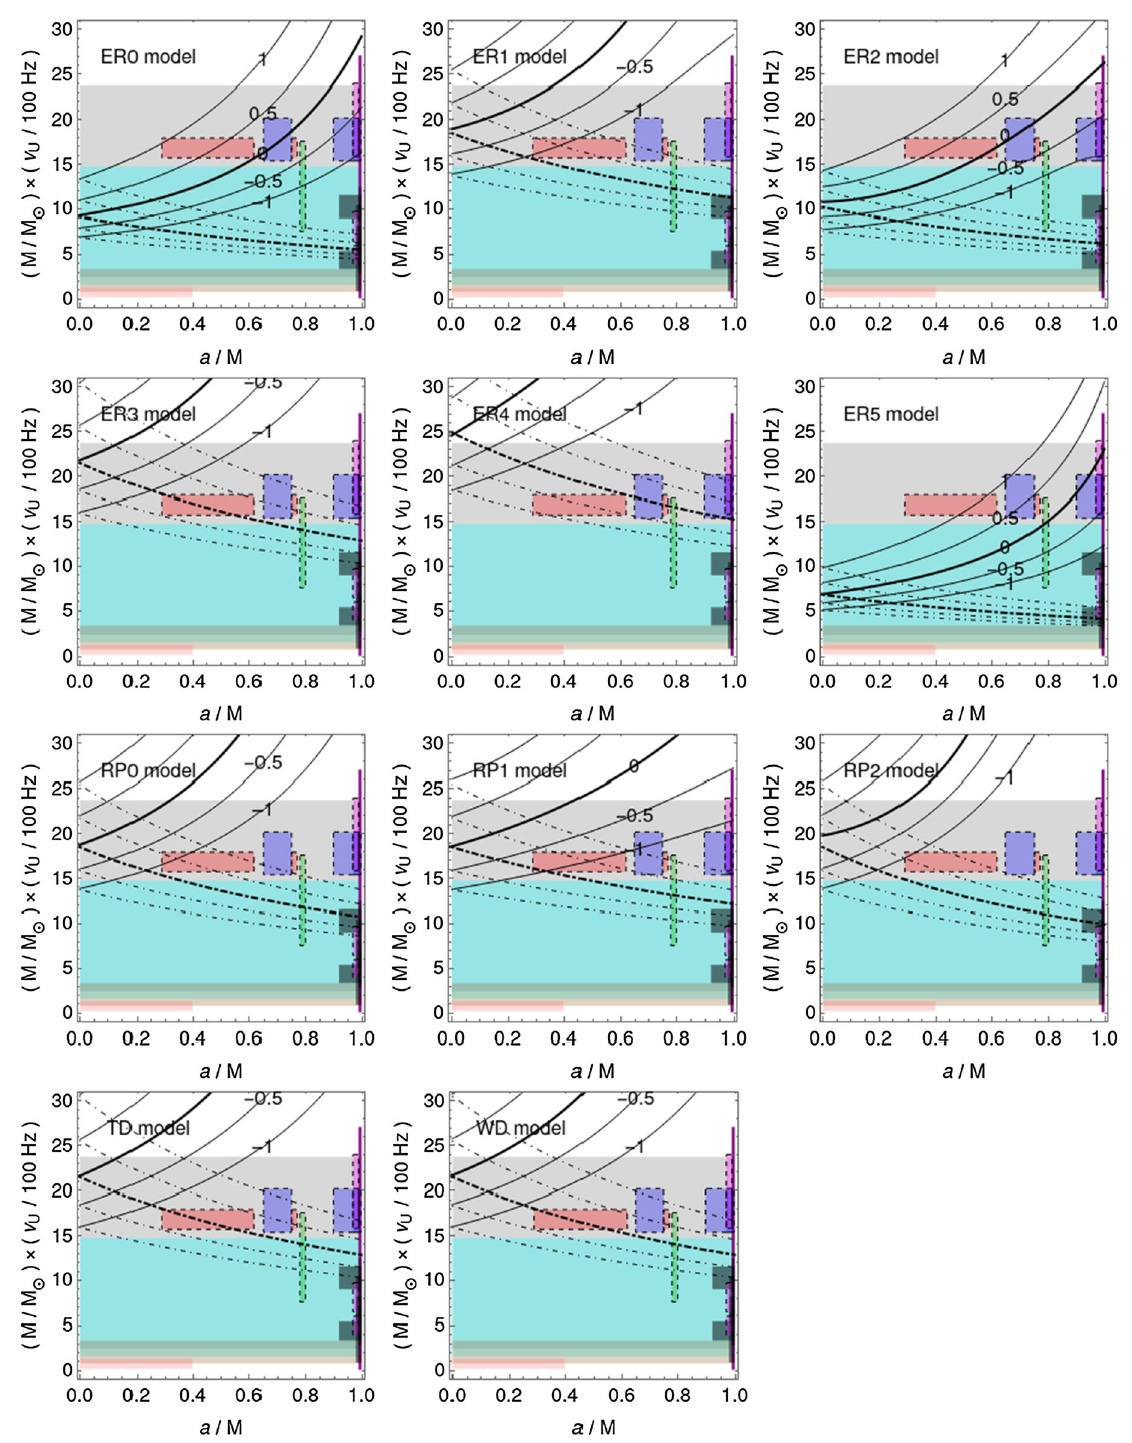
Fig. 6 Fitting of quasars and AGNs with different spinning parti- cle HF QPOs models. On the horizontal axis the BH spin a / M is given, while on the vertical axis we give BH mass M multiplied by observed upper HF QPOs frequency μ U . Boxes represent the observed mass-frequency M · f and spin ˜ a values for various microquasar and AGNs (microquasars have dashed boundary), see Table 1, and Fig. 4.